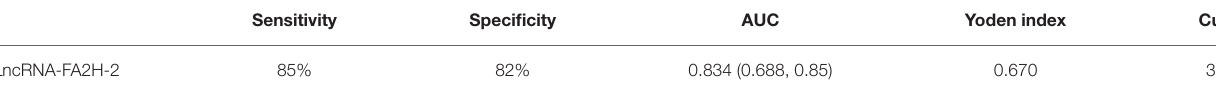
TABLE 11 | Comparison of the sensitivity and specificity of LncRNA-FA2H-2.